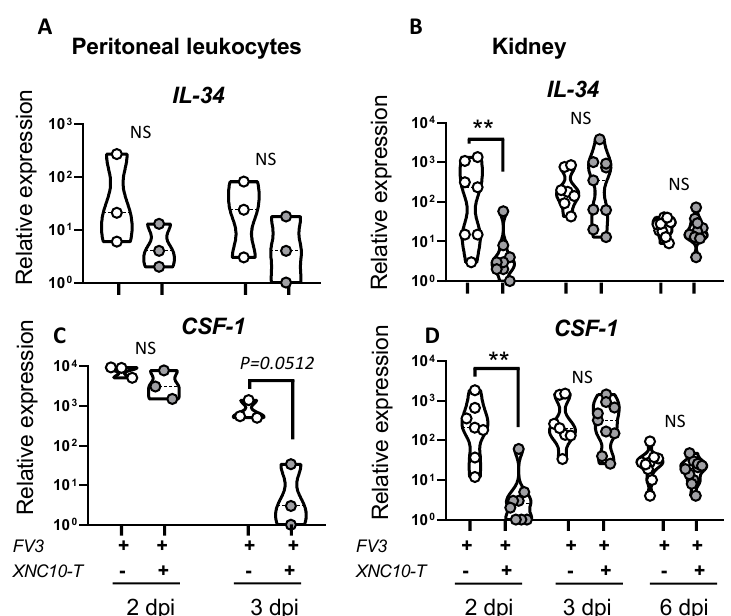
Figure 6. E ff ect of XNC10 tetramer treatment on the expression of the macrophage stimulating factor genes CSF-1 and IL-34 in the peritoneal cavity and kidneys of FV3 infected tadpoles. PLs and kidneys were collected from three week-old (stage 55) tadpoles that had been injected with 1 µ g XNC10 tetramers or vehicle control 1 day pre- and 1 day post-i.p. injection with 10,000 PFUs of FV3, at the indicated time points ( n = 8–9). Quantitative gene expression analysis of IL-34 ( A , B ) and CSF-1( C , D ) were determined relative to a endogenous control (GAPDH), and relative expression was calculated against the lowest observed expression according to the ∆∆ Ct method ( n = 9); ** p < 0.005 above the line denotes statistically significant di ff erences between the di ff erent treatment groups; NS indicates no significant di ff erences (One way ANOVA followed by Tukey’s multiple comparison